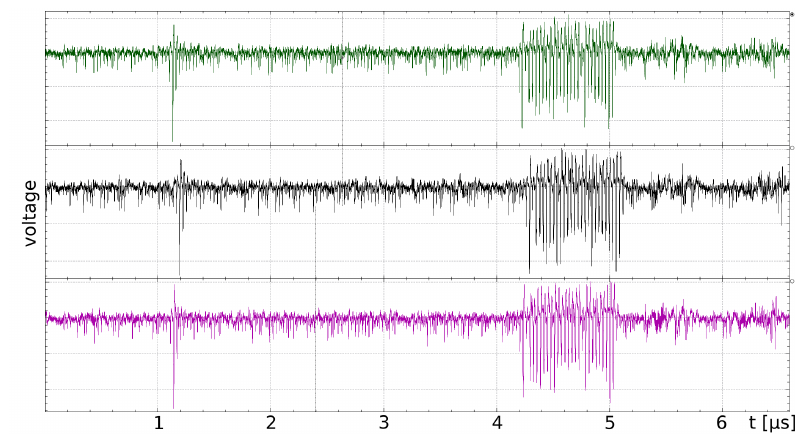
Figure 10: Three EM traces showing DES executions at a manually selected position measured with a 500 µm